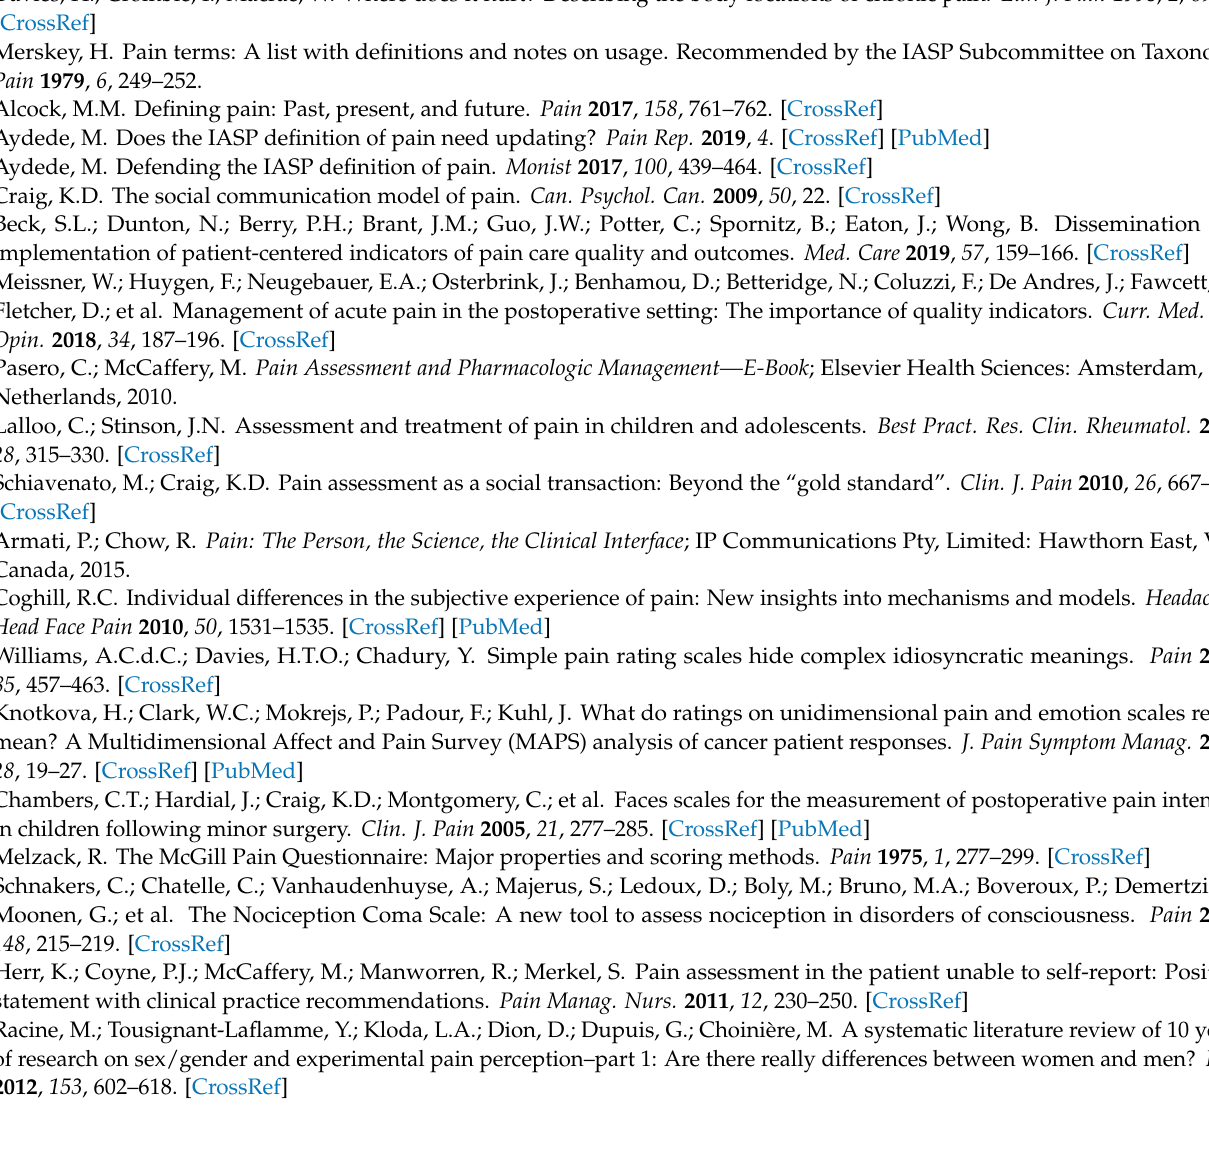
Although yielding good results for no pain vs. low pain, Thiam’s network does not perform better for tasks no pain vs. high pain ( T 0 vs. T 4 / B vs. P 4 ). Because of the obtained results and the higher complexity of Thiam’s network, it was not used in our experiments. Moreover, there is a discrepancy between accuracy results reported in Thiam et al. [30] and the ones yielded in our setup. Differences can be argued by variations in the pre-processing chain and unequal evaluation scheme using a single LOSO scheme and a 5 × LOSO average in [30] and our framework,